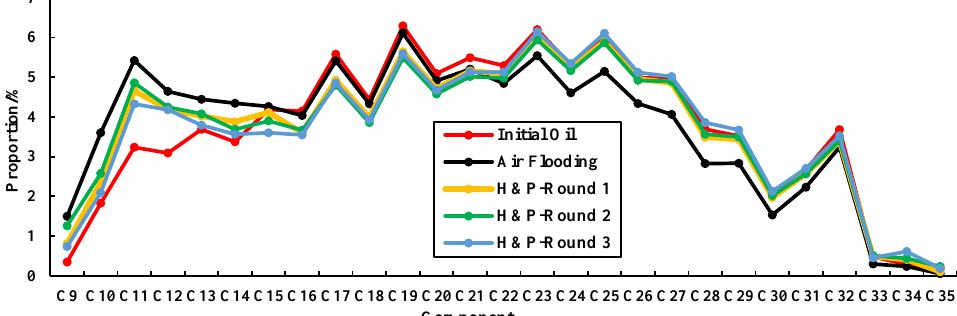
Figure 14. GC results of initial oil and produced oil.